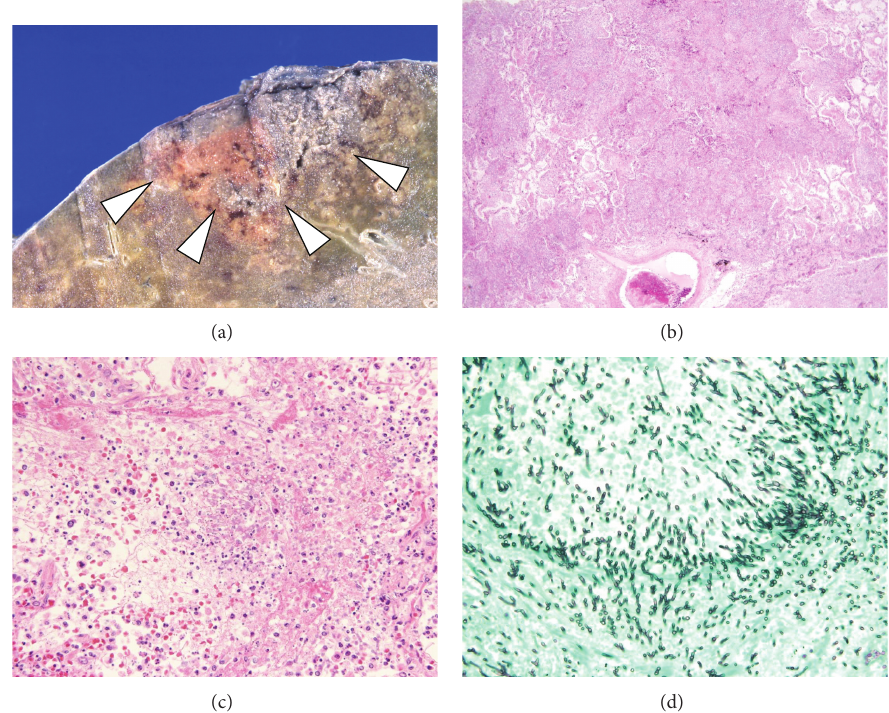
Figure 2: Invasive pulmonary aspergillosis, fused lobular consolidation. (a) The lesion comprising a fusion of solidified lobules is seen on a section of lung (white arrow head). The necrotic cavity is usually present at the center. (b) Ordinary bronchopneumonia can be seen (Hematoxylin-Eosin, X20). (c) Alveoli present due to the invasion of hyphae are filled with neutrophils (Hematoxylin-Eosin, X200). (d) Growth of fungus is present in the airspace (GMS,